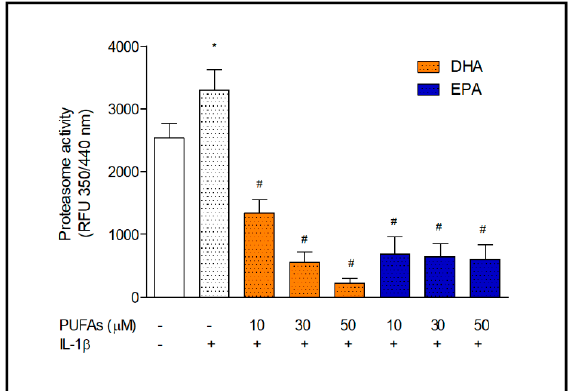
Figure 3. Proteasome activity in IL-1 β -stimulated astrocytes incubated with various concentrations